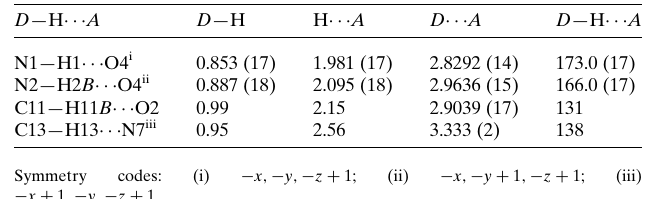
Table 1 Hydrogen-bond geometry (A˚ , (cid:3) ).